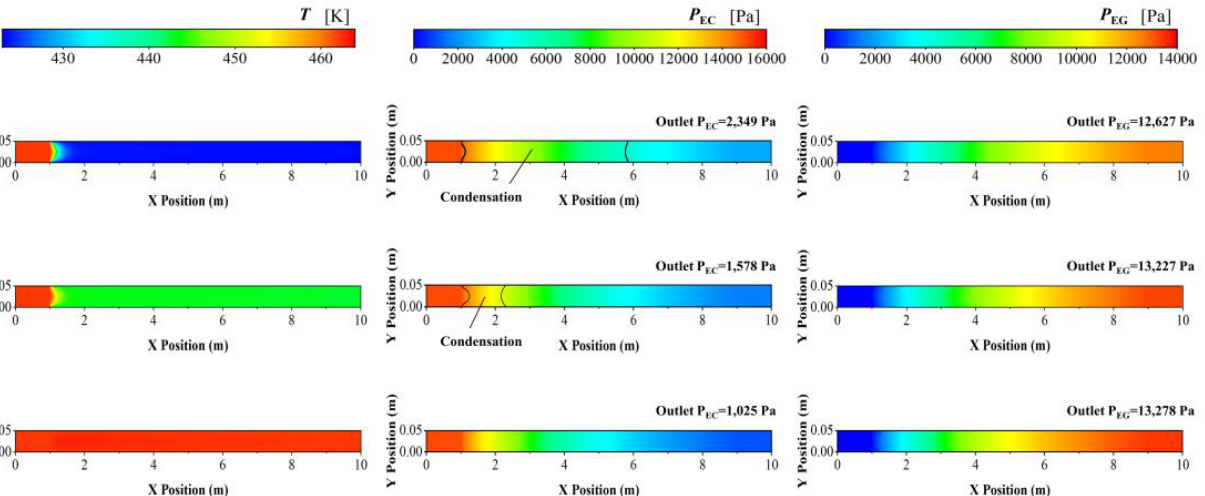
Figure 4. Contours of 𝑇 , 𝑃 and 𝑃 in the adiabatic reactor with different reactant inlet temper- EC EG atures of ( a ) 443 K, ( b ) 463 K and ( c ) 483 K under the conditions of 3 MPa, 0.3 g EC ·gcat − 1 ·h − 1 and H 2 /EC = 200.